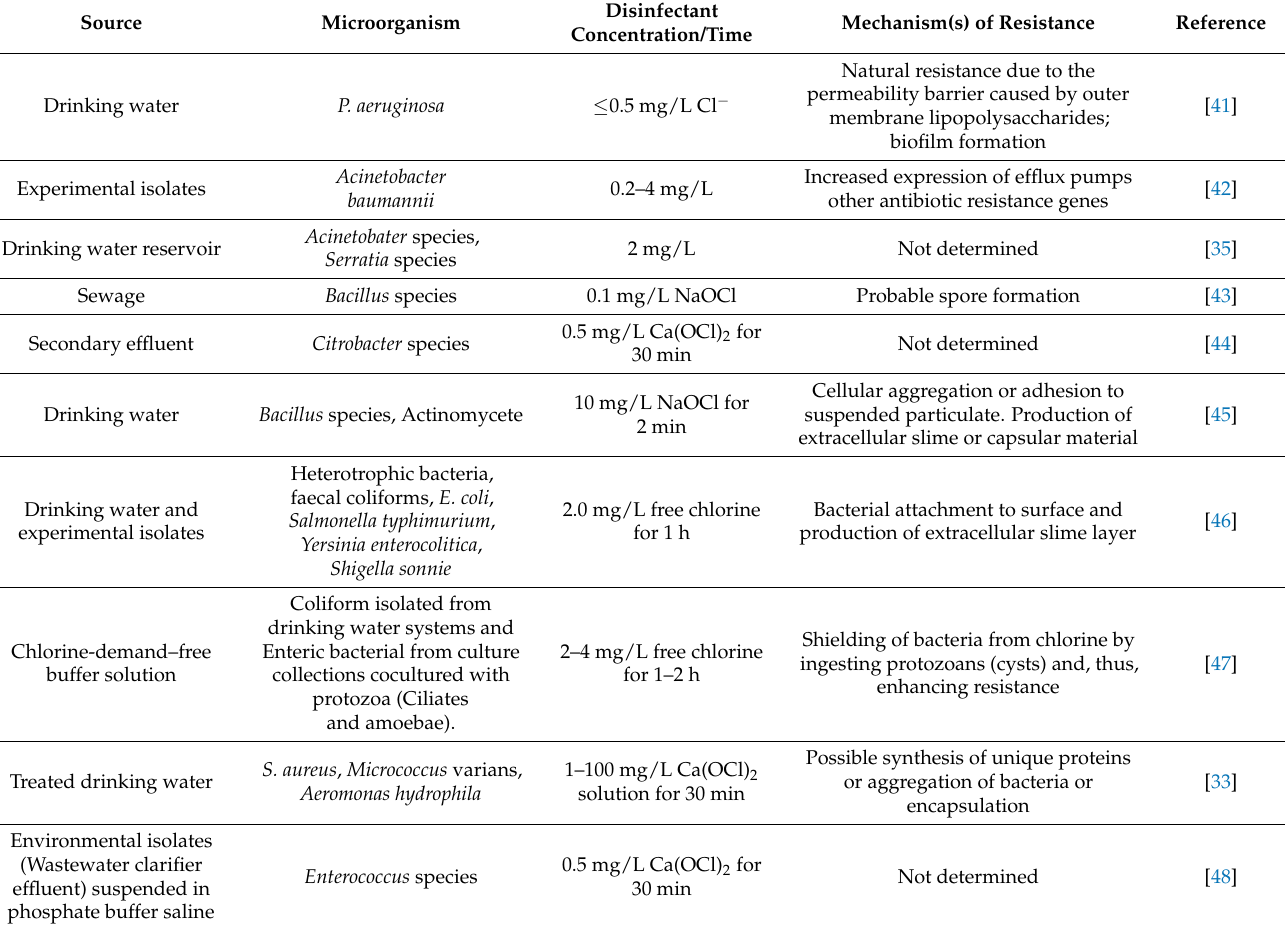
Table 1. Summary of some reports of disinfectant-resistant microbes isolated from diverse aquatic